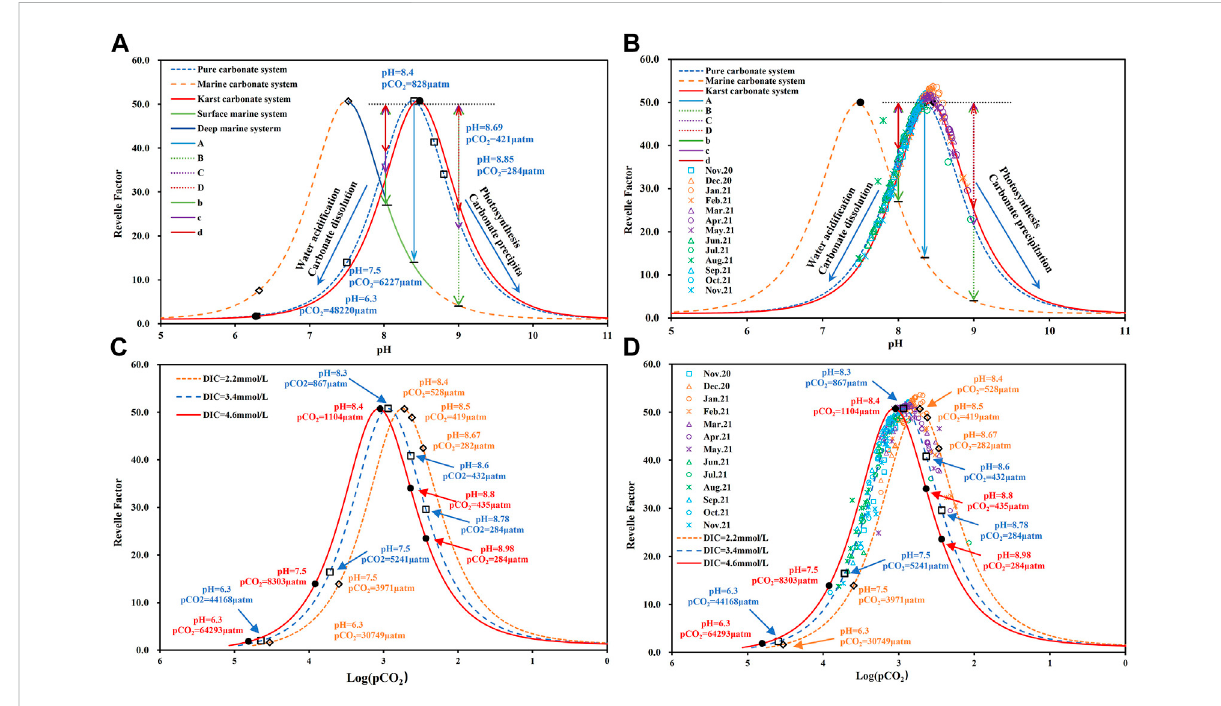
FIGURE 2 (A) Correlation between the Revelle factor and pH under different aqueous media conditions; (B) Relationship between the Revelle factor and pH in the Huatan River watershed; (C) Correlation between the Revelle factor and Log(pCO2) under different DIC concentration conditions; (D) Relationship between the Revelle factor and Log (pCO 2 ) in the Huatan River watershed.